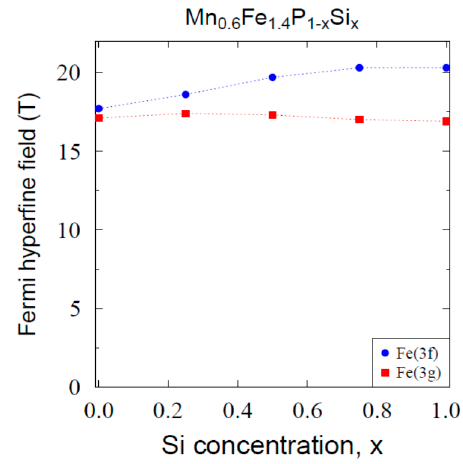
Figure 14. Hyperfine field versus Si concentration in Mn 0.6 Fe 1.4 P 1 − x Si x.